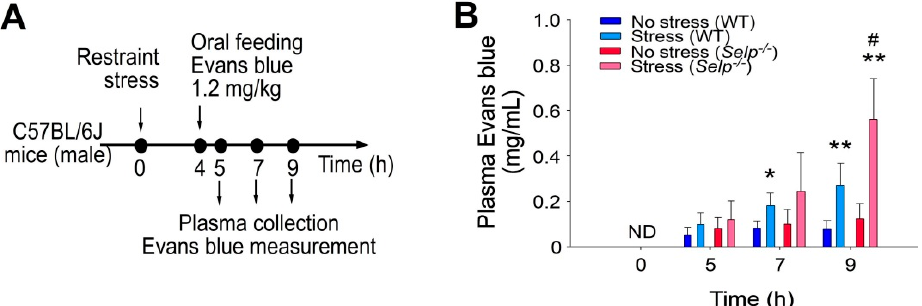
Figure 2. P-selectin deficiency exacerbates restraint stress-induced GI leakage in mice. ( A ) Experiment outline of restraint stress mouse model with Evans blue treatment. ( B ) Plasma Evans blue levels of wild-type (WT; C57BL/6J; Selp +/+ ; male) and P-selectin gene knockout (KO; Selp − / − ; male) mice with or without restraint stress at 0, 5, 7, and 9 h. ND: not detected. Error bars shows standard deviation; * p < 0.05, ** p < 0.01, vs. respective no stress control groups; # p < 0.05, vs. WT groups. n = 6 (three experiments with total six mice per group).